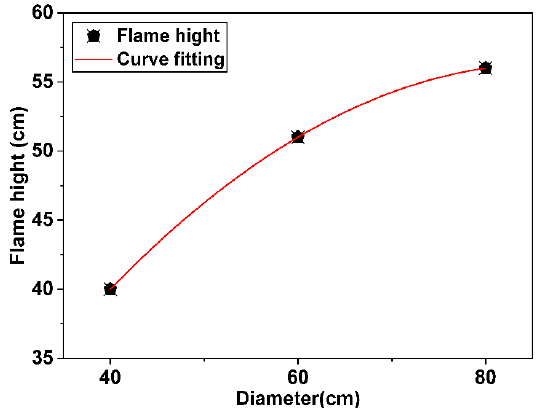
Figure 8. The flame height fitting curve with different diameters.